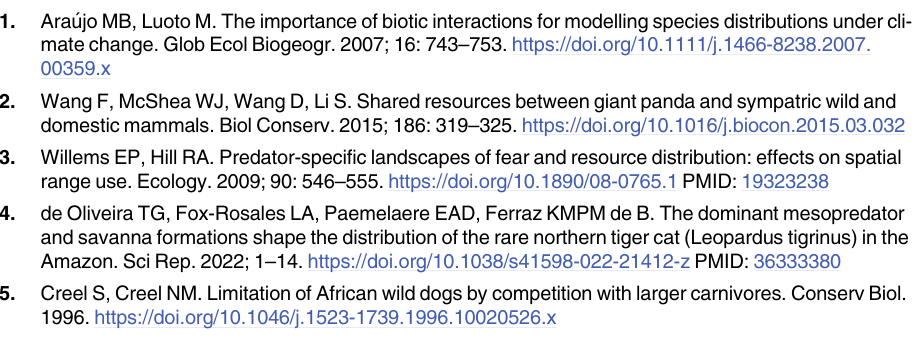
S1 Table. Full model selection table. C represents the probability of habitat use (occupancy parameter), p represents the detection parameter. Species codes are as follow: 1 = northern tiger cat; 2 = jaguarundi; 12 = both. k indicates the number of parameters for each